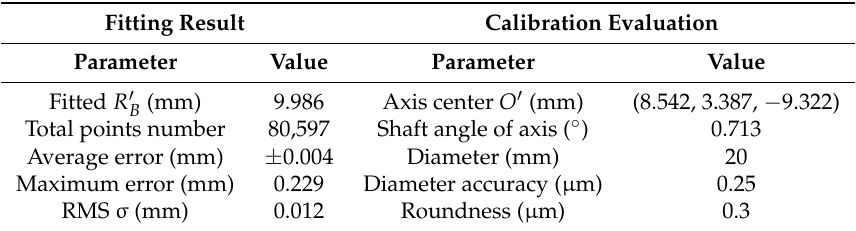
Table 4. The turntable calibration and fitting statistics of the spherical